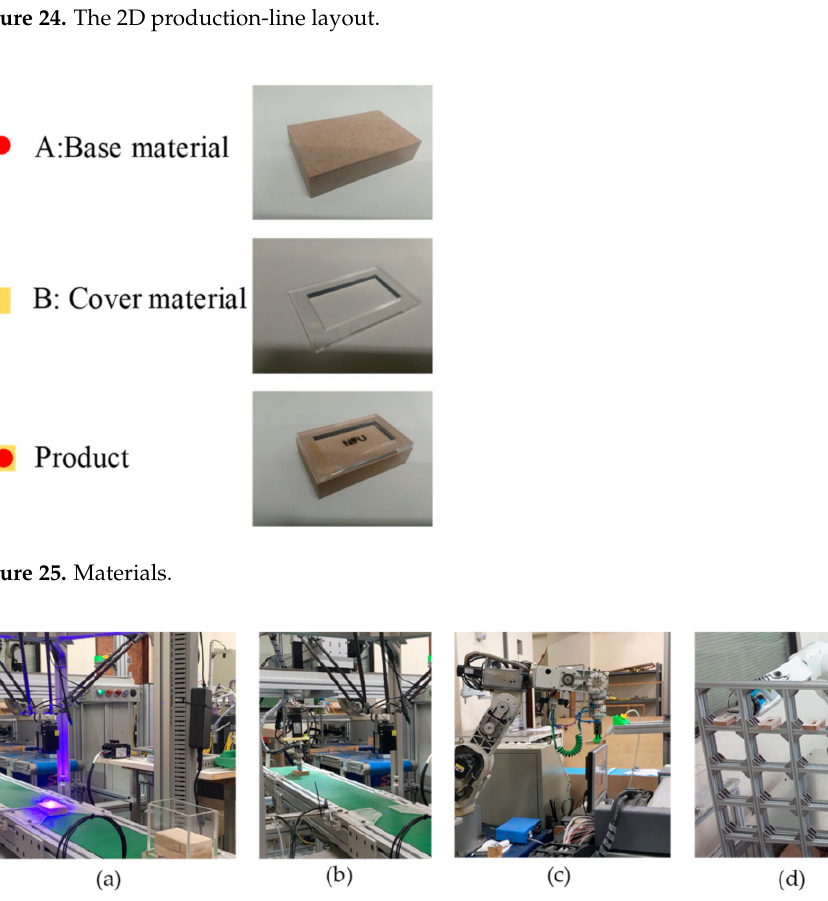
Figure 26. ( a ). Stations 1 and 2. ( b ) Station 3. ( c ) Station 4. ( d ) Station